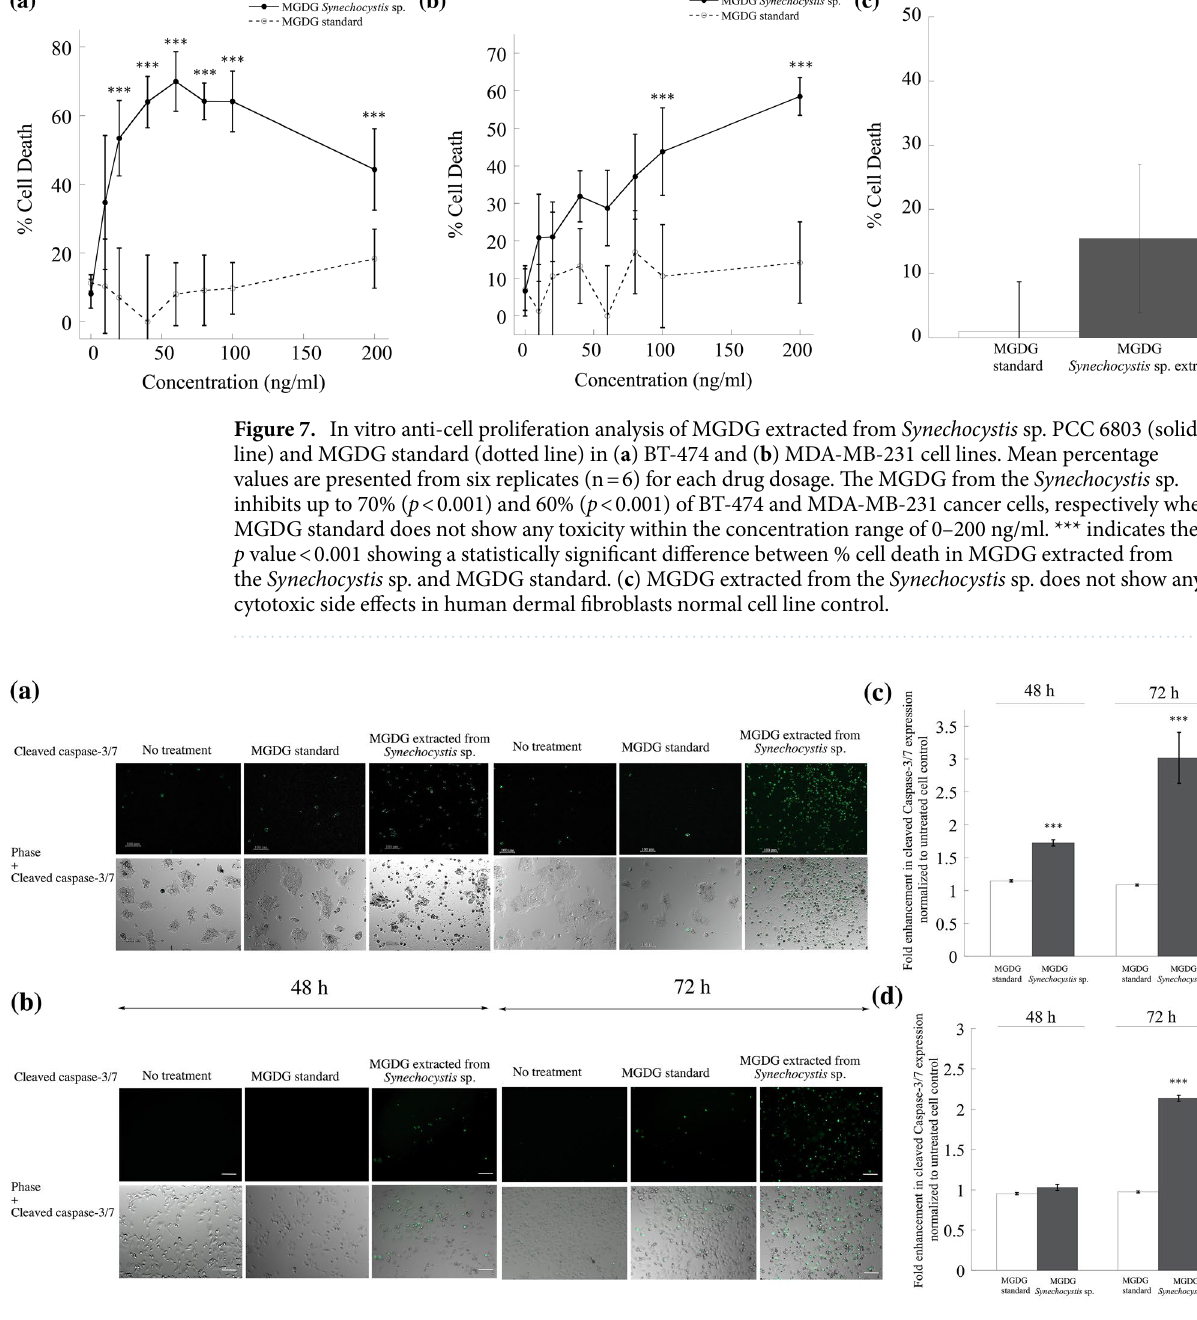
Figure 8. In vitro apoptosis induction by MGDG extracted from the Synechocystis sp. and MGDG standard after 48 and 72 h treatments in ( a ) BT-474, and ( b ) MDA-MB-231 cells. The green fluorescence of apoptotic caspase-3/7 proteins increases in both BT-474 and MDA-MB-231 cells treated with MGDG extracted from the Synechocystis sp. The combined phase contrast and the fluorescence images show that the cyanobacterial extracted MGDG enhances the intensity and density of green fluorescence cells indicative of caspase-dependent apoptosis in both cell lines. In contrast, cells treated with MGDG standard molecule did not show any sign of apoptosis in either cell line even after 72 h of treatment. The scale bars represent 100 μm. Quantification of the active caspase-3/7 expression in ( c ) BT-474, and ( d ) MDA-MB-231 cells treated with MGDG extracted from the Synechocystis sp. and MGDG standard after 48 h and 72 h of treatments. In BT-474 cells, the active caspase-3/7 expression was increased by 1.7 ( p < 0.001) and 3 ( p < 0.001) fold after 48 h and 72 h treatments, respectively compared to untreated control. The increase in caspase-3/7 expression was 2.1 ( p < 0.001) fold after 72 h treatment in MDA-MB-231 cells compared to the untreated control. Mean ± standard deviation from two independent experiments in at least three replicates (n = 6) are presented. *** indicates the p value < 0.001, showing a statistically significant difference compared to untreated control